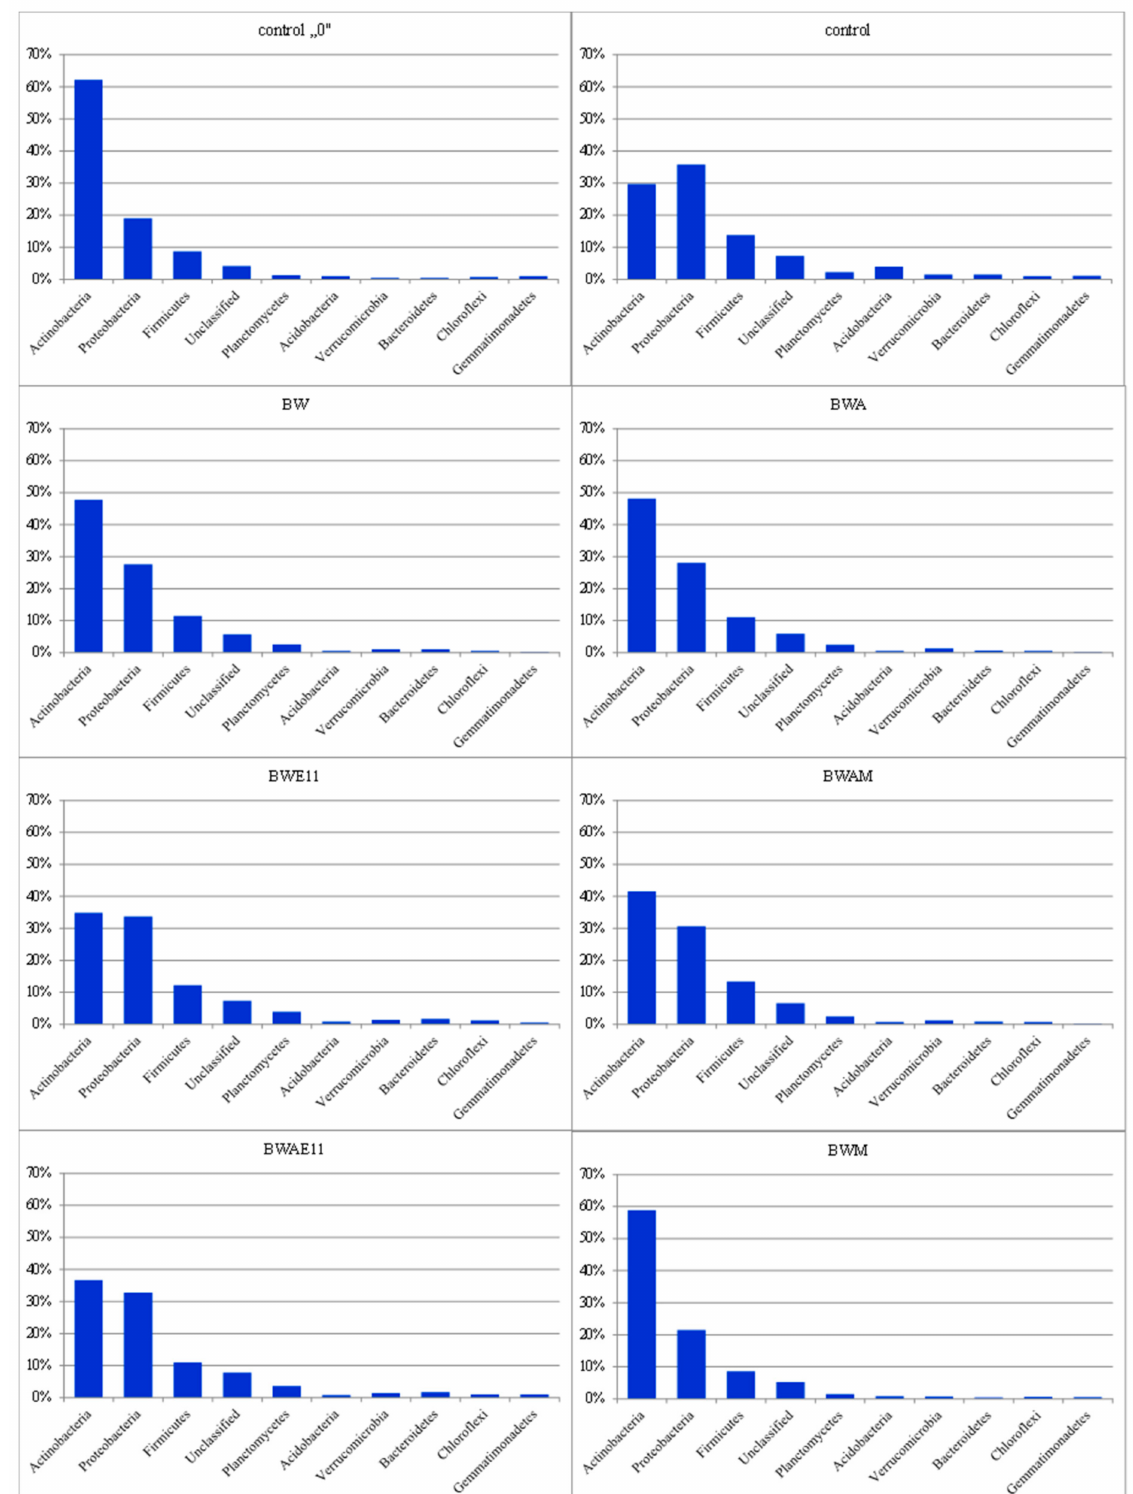
Figure 1. The percentage content of selected bacterial phylum in the experimental variants. Explanation: control ‘0’—without fertilisers and plant cultivation, control—the control variant without fertilisers, with plant cultivation, BW— biochar fertiliser, BWM—biochar fertiliser with mycorrhizal fungi, BWE11—biochar fertiliser with Bacillus bacteria, BWA— biochar fertiliser with algae, BWAE11—biochar fertiliser with algae and Bacillus sp. bacteria, BWAM—biochar fertiliser with algae and mycorrhizal